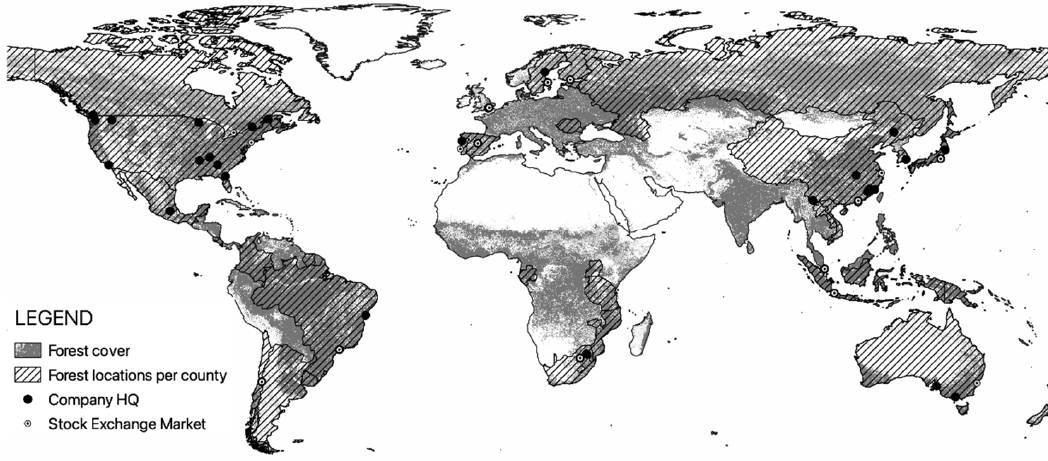
Figure 1. World map with forest areas managed by publicly traded companies.